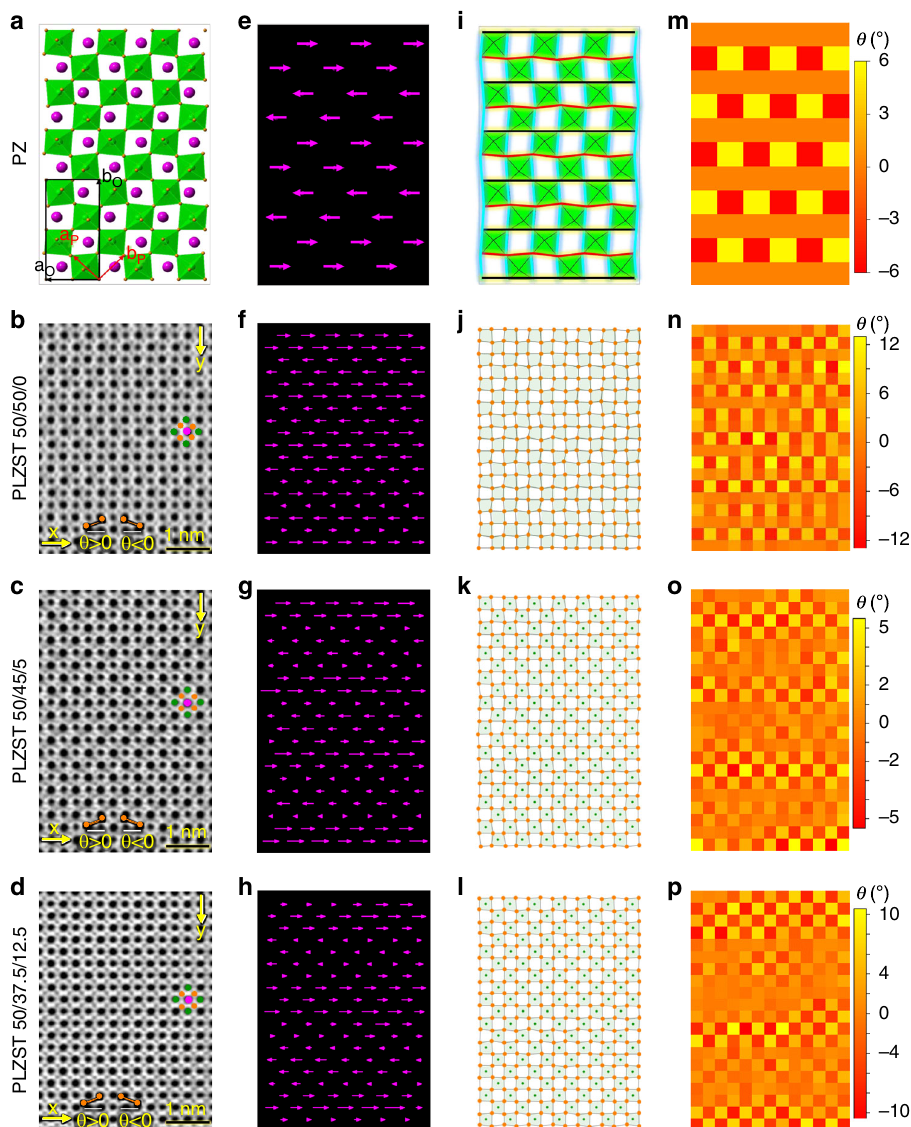
Fig. 3 Structural mapping of the coupling between O-anions displacement and A/B-cations displacement. a – d The [001] p projected structure of PbZrO 3 AFE phase (ref. 11 ) and experimental ABF images of PLZST system, where purple, green, and orange balls represent A-cations, B-cations, and O-anions, respectively. The axis of “ a O /b O ” and “ a P /b P ” refer to orthorhombic and pseudocubic unit cell, respectively. The directions of “ x/y ” are de fi ned as the [ (cid:1) 110] p /[ (cid:1) 1 (cid:1) 10] p , respectively. e – h , ( i – l ), and ( m – p ) are the corresponding mappings of relative cations displacement ( D AB ), tilts and distortion of BO 6 octahedra, and y-rippling of O-sublattice, respectively. The black/red/cyan lines in ( i ) highlight the displacement behaviors of O-anions along x- and y- direction in PbZrO 3 . The ( e – h ) only show the horizontal component of D AB for clarity. The color scales represent local amplitude of y-rippling of O- sublattice, which is de fi ned as Ɵ , i.e., the angle between O – O bond in a row and horizontal x-direction. The mapping of x-rippling of O-sublattice is not shown because it can be accessible in the corresponding quantitative pro fi les presented in Fig. modulated in corresponding period. Speci fi cally, fi rstly, the in which the displacement of O-anions has approximately equal PLZST 50/50/0 has a similar way to PbZrO 3 , but there is a positive and negative value (Fig. 4d). Apart from the difference in phase difference about one d 110 between A-cations and B-cations/ coupling behavior, the displacement amplitude of both A/B- cation and O-anion gradually decrease with decreasing of Sn/Ti O-anions (Fig. 4b). The horizontal displacement of O-anions in (cid:1) Fig. 4b refers to the data of odd column while its comparison to ratio, consequently led to the decrease of intensity of 1/2{11 1} the displacement of even column and the sum of both columns re fl ections in XRD (Fig. 1a) and SAED (Supplementary Fig. 1) as are presented in Supplementary Fig. 7. Secondly, the PLZST 50/ well. Of particular interest is that the displacement of O-anion 45/5 shows inverse behavior to PbZrO 3 , i.e., B-cations move in gradually changes its position with the reference of zero-line the opposite direction to Pb-cations while O-anions move in while the A-cations maintain the unbalanced displacement in accordance with A-site cations, synchronous alternation of large all three compositions. Thus, the displacement of O-anion is positive value and small negative value (Fig. 4c). Thirdly, the also strongly affected by the doping effect of B-site elements. PLZST 50/37.5/12.5 presents nearly the same fashion as PbZrO 3 , For instance, the stronger hybridization between B-cation and